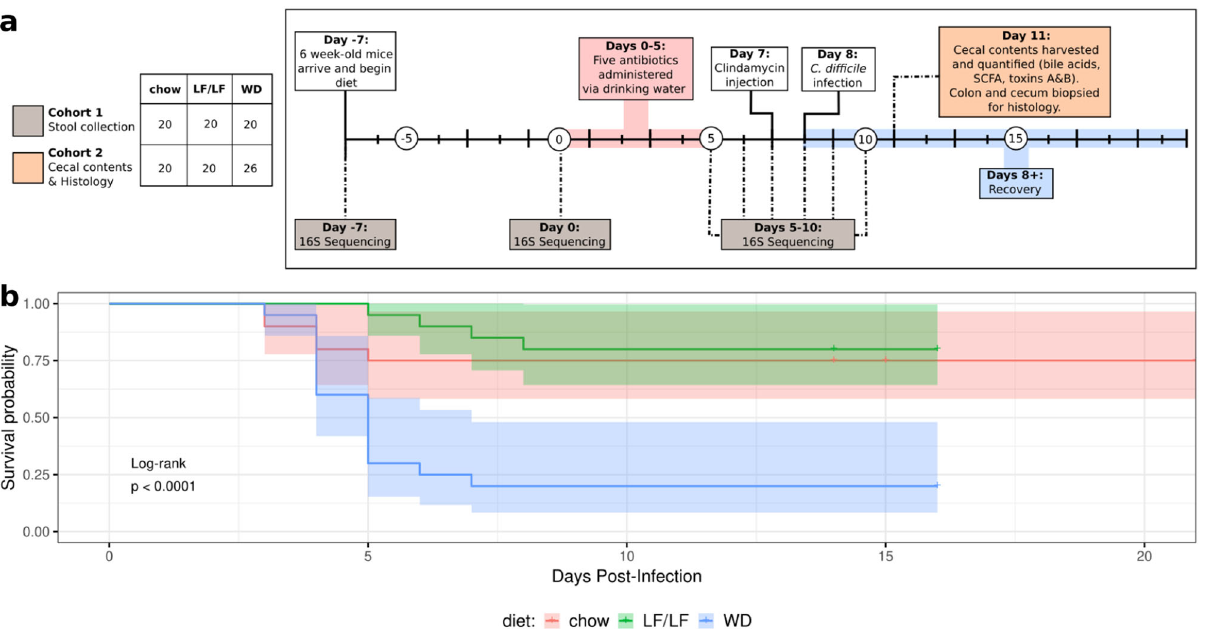
Fig. 1 Experimental design of the murine model of antibiotic-induced CDI and survival curves. a C. dif fi cile challenge experimental design. The fi gure legend at the left panel indicates the samples sizes for 2 cohorts; more information on batching and n ’ s per assay is given in Supplementary Table 2. Cohort 1 was followed for 13 days post C. dif fi cile gavage to monitor survival and gut microbiome composition over time. Cohort 2 was sacri fi ced at 3 days post C. dif fi cile gavage to collect cecal contents for measurement of metabolites and toxin and colon and cecal mucosa for histopathology (some assays were only conducted on a subset of Cohort 2, but all in at least two independent experiments; see Supplementary Table 2 for details). Gray and orange boxes indicate the time points at which samples were collected for the respective cohorts. b Survival curves on the three diets. Statistical signi fi cance as assessed by log-rank comparison is